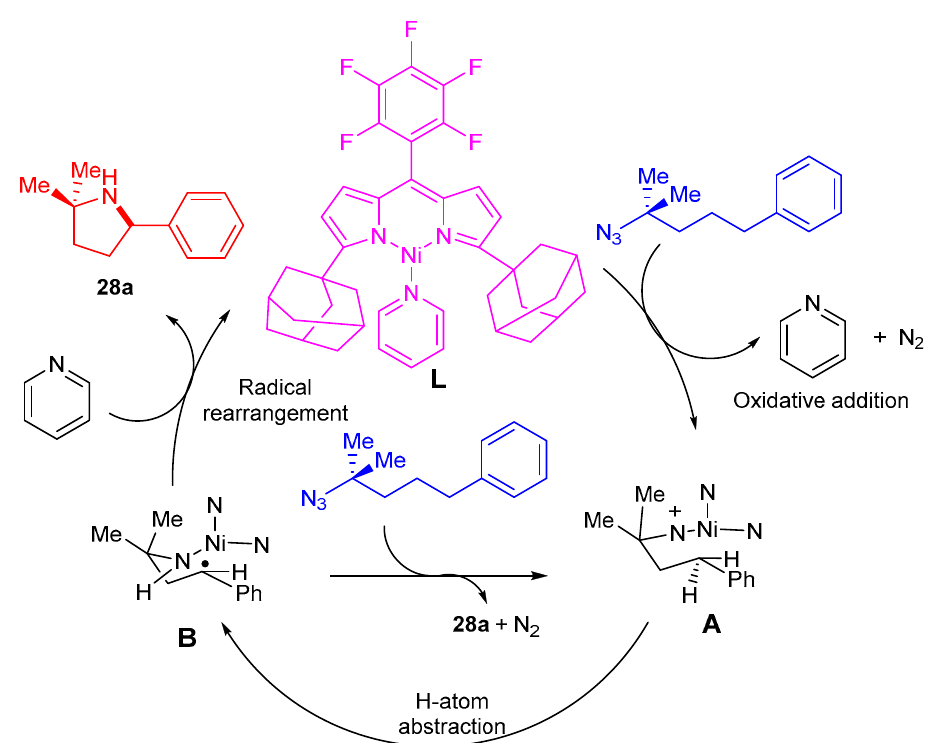
Molecules 2022 , 27 , x FOR PEER REVIEW 12 of 81 Scheme 17. Synthesis of pyrroles and its fused systems 28l – aa . Reagents and conditions : (a) 1 mol% ( AdF L)Ni(py), C 6 D 6 , 60